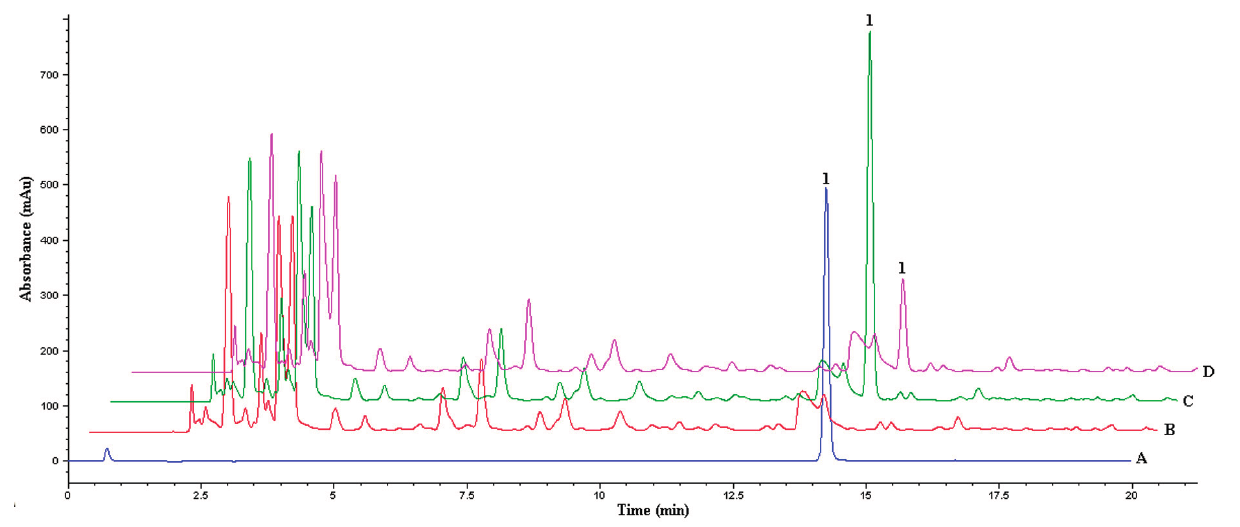
Figure 8. Chromatograms corresponding to (A) 2-deoxyadenosine in H 2 O; (B) urine sample; (C) urine spiked with 2-dA; and (D) urine after MIM incubation with spiked-urine. Peak identification 1: 2-deoxyadenosine